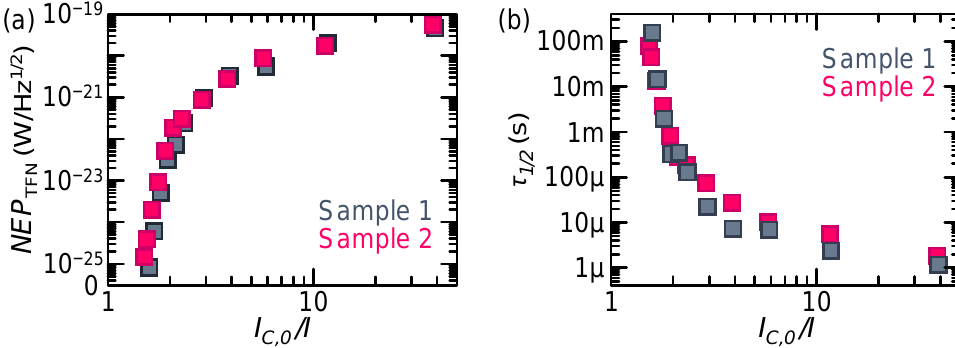
Figure 6. Deduced properties of a JES. ( a ) Thermal fluctuations limited NEP as a function of the ratio I C ,0 / I for two different 1D-JJs. The NEP improves of about six orders of magnitude by increasing I . ( b ) JES bolometer time constant ( τ 1/2 ) as a function of the ratio I C ,0 / I for two different 1D-JJs. The high current operation decreases the speed of the